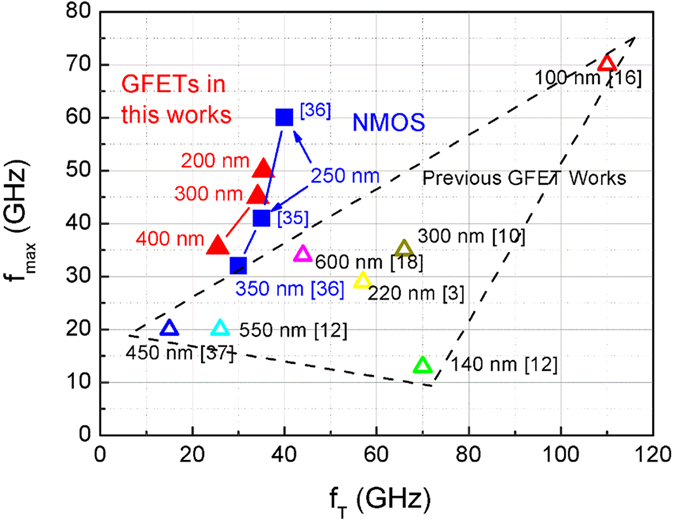
Comparing fT and fmax of published GFETs, Si n-channel MOSFETs and GFETs in this work.Solid blue squares: Si n-channel MOSFETs at 0.25 μm3536 and 0.35 μm36 technology nodes. Solid red triangles: GFETs in this work. Hollow triangles: published submicron GFETs31012161837.